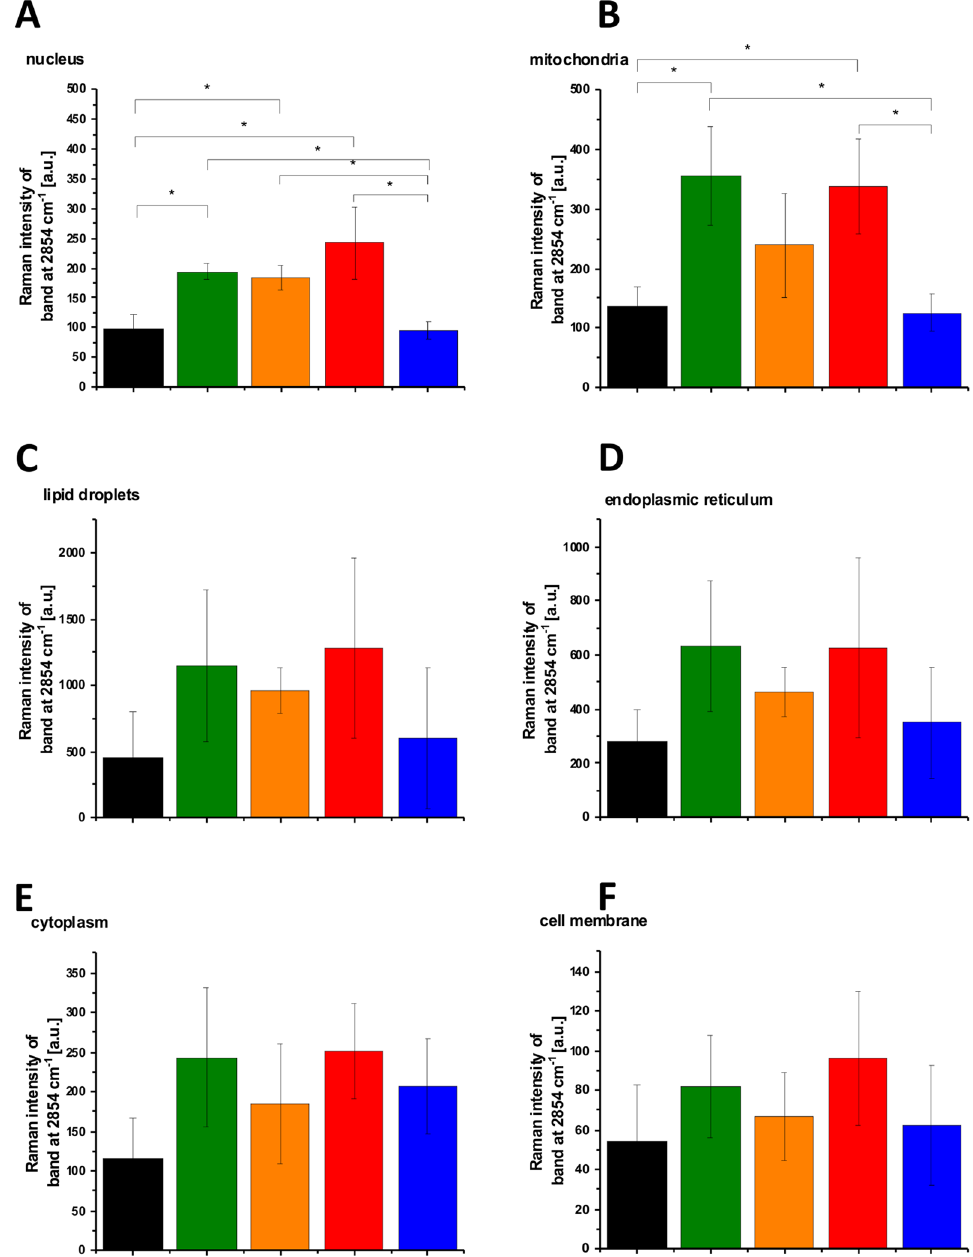
Figure 6. The Raman intensity band at 2854 cm −1 of human lung single cell CCL-185 without glucose supplementation (black line), supplemented with nondeuterated glucose (green line) and deuterated glucose (red line) at normal conditions (5 mM) and supplemented with nondeuterated glucose (orange line) and deuterated glucose (blue line) at hyperglycemia conditions (100 mM). The one-way ANOVA using the Tukey test was used to calculate the value significance, the asterisk * denotes that the differences are statistically significant, p-value ≤